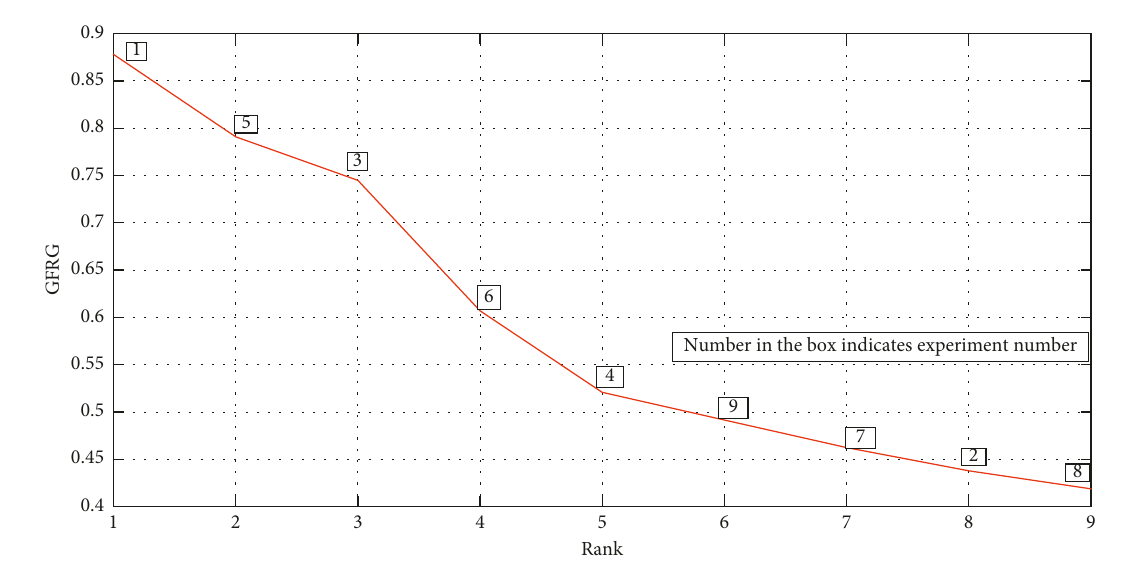
Figure 11: GFRG for the responses. shown in Figure 10. The comparison between grey relational grade and the grey-fuzzy reasoning grade is as shown in Figure 13.